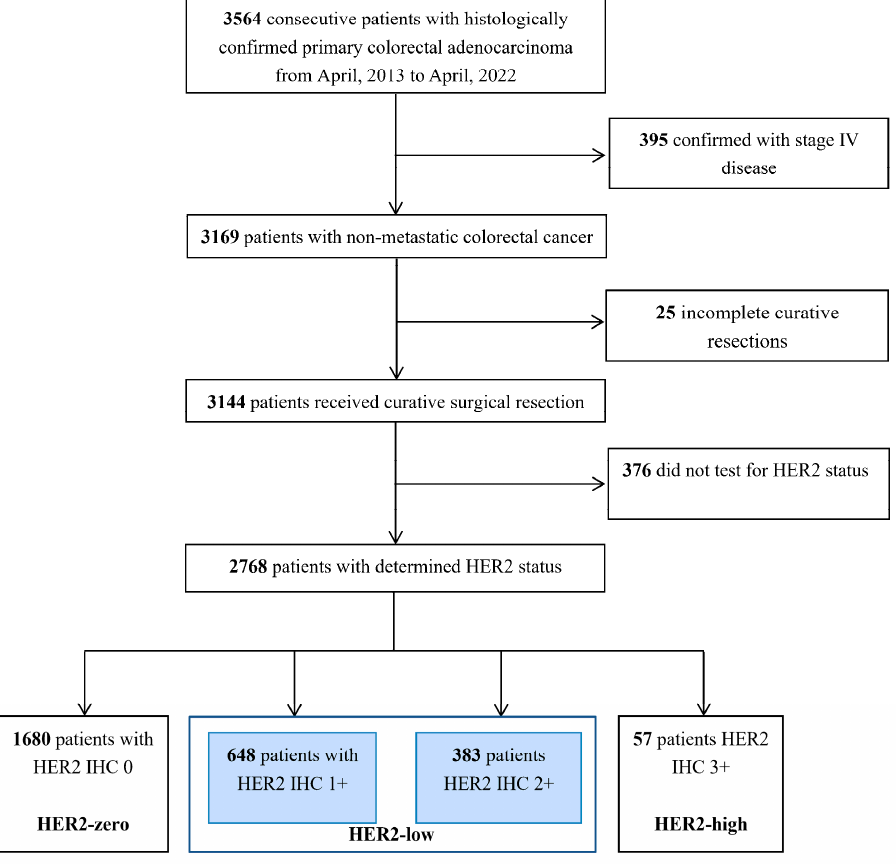
Figure 1. Diagram of the study design.